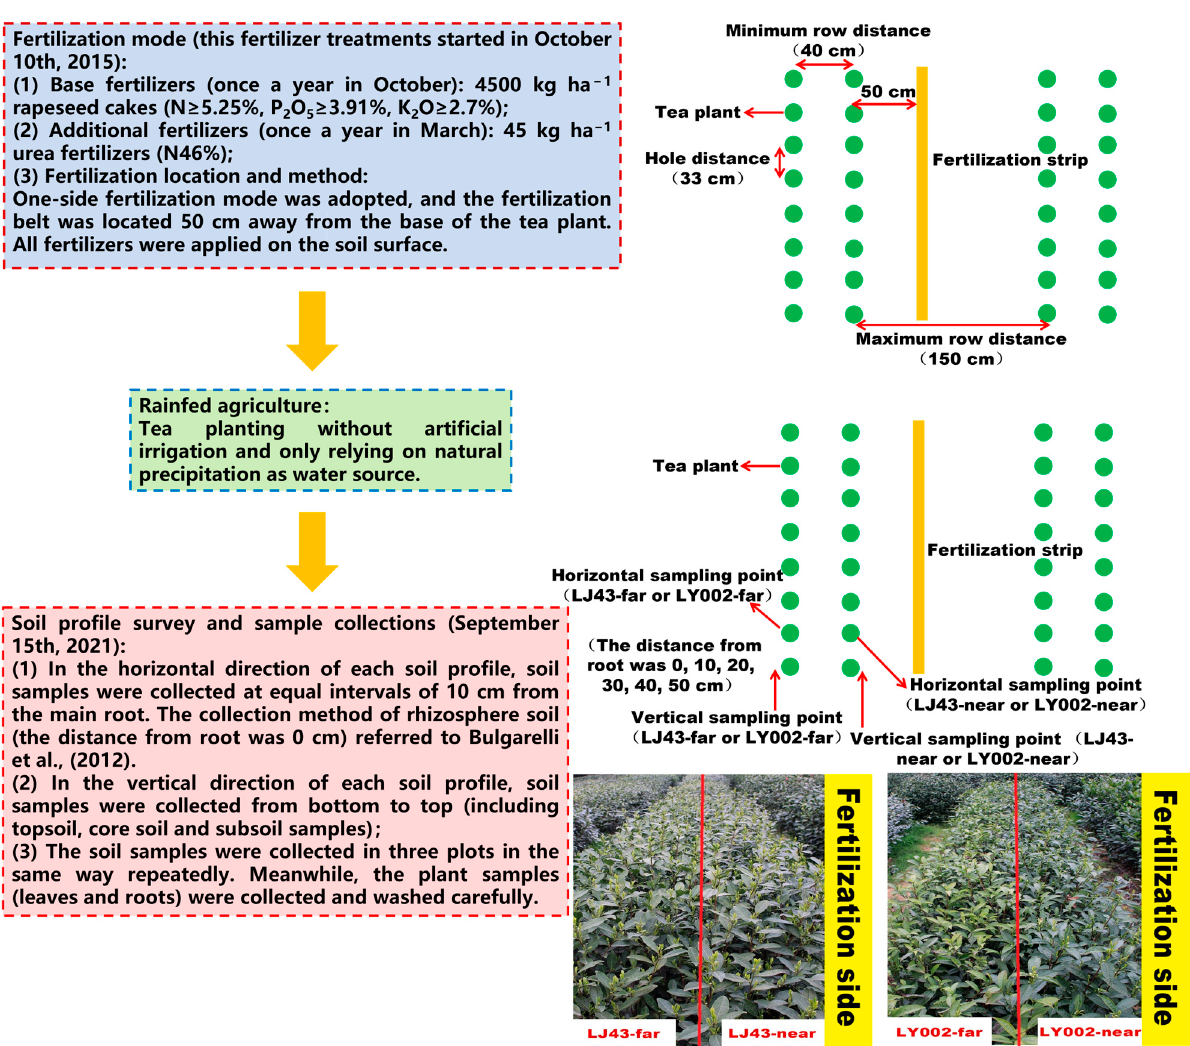
Figure 7. The flowchart of the whole experiment (including when applied treatments, irrigation, fertilization, when sampling of soil or plants and how, etc) [25,41].